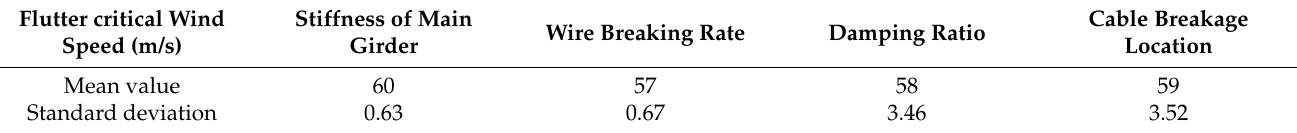
Table 9. Statistic parameters of the flutter critical wind